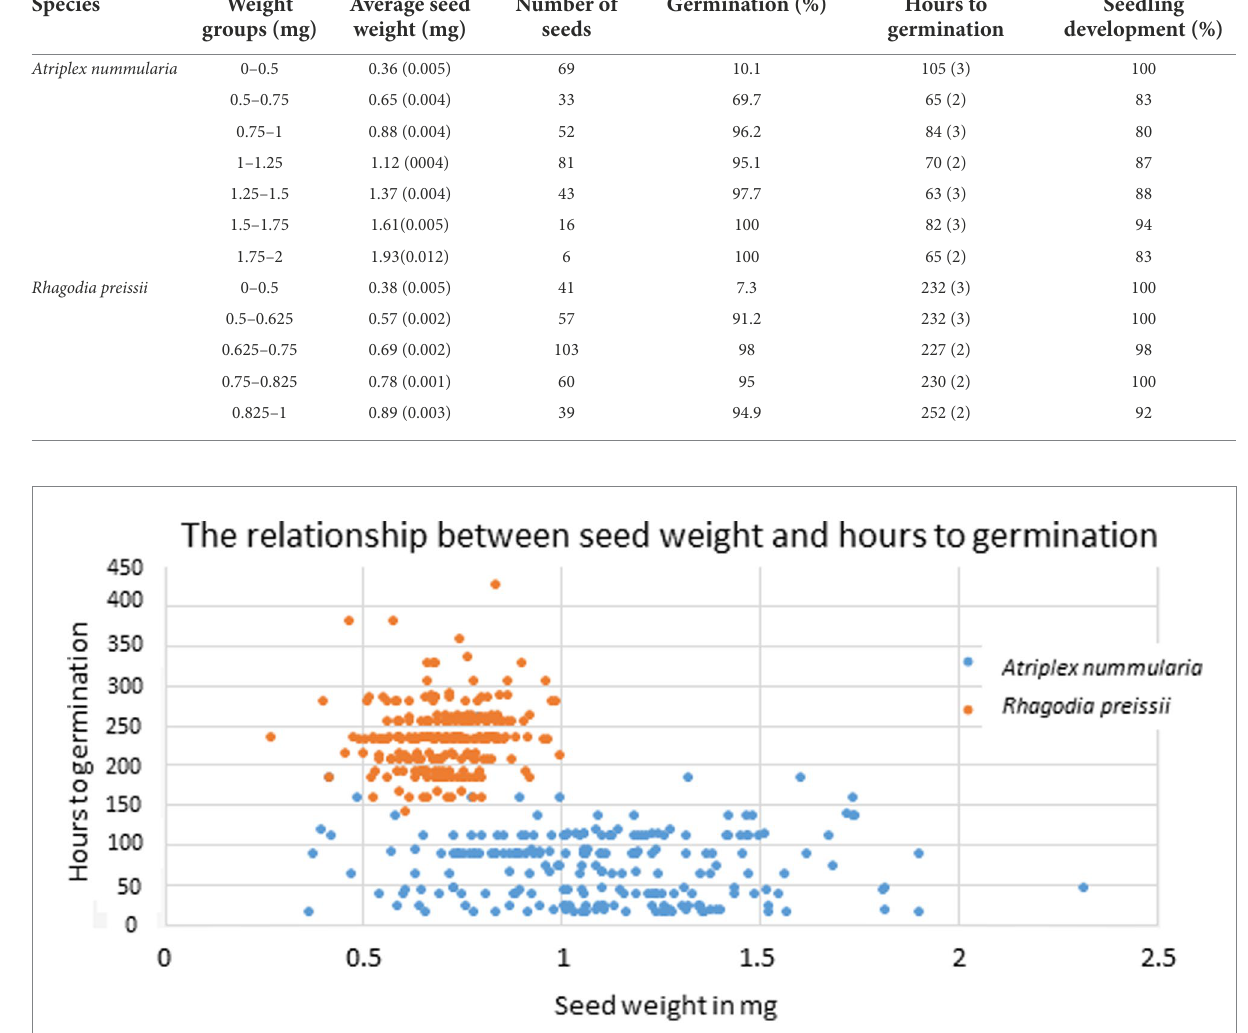
FIGURE 5 Scatter plot showing the correlation between individual seed weight and the number of hours to germination for A. nummularia (blue) and R. preissii